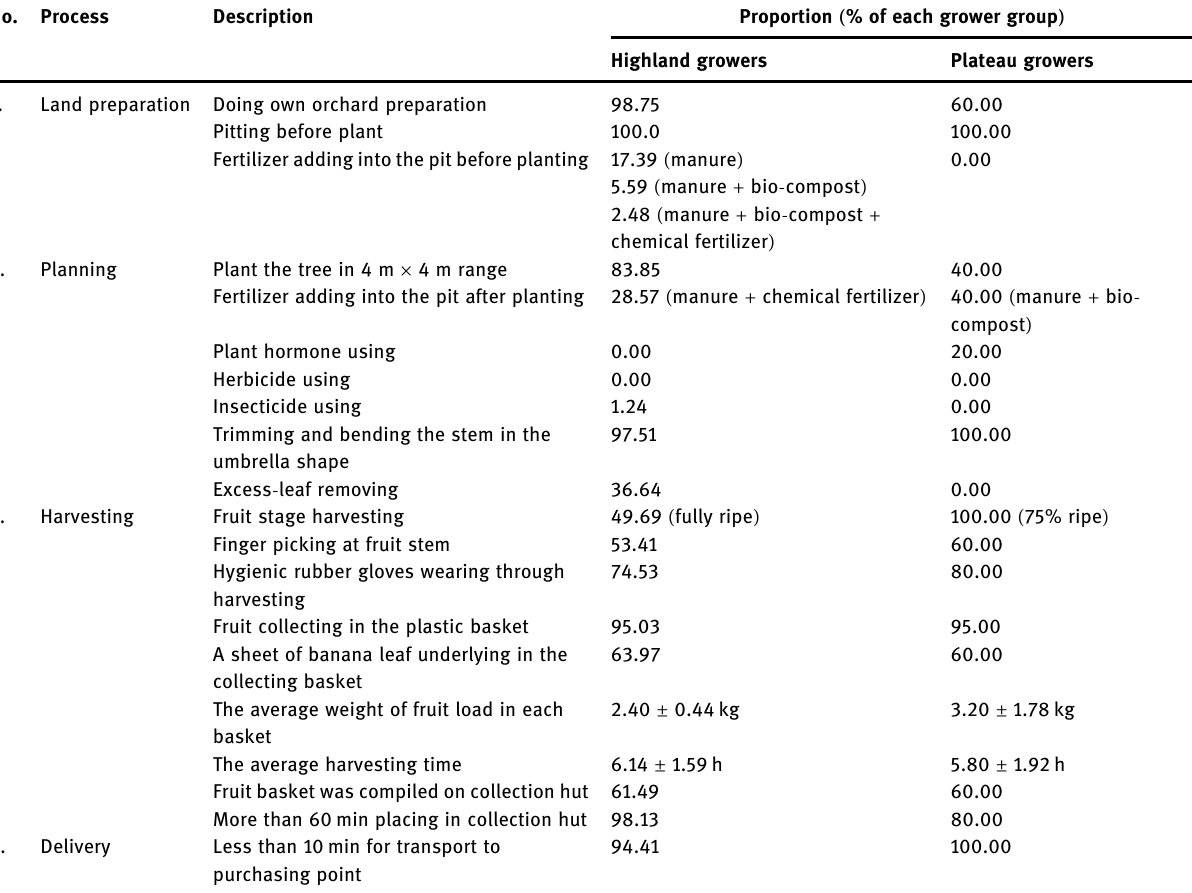
Table 2: Details of mulberry growers ’ production processes in the highland and plateau No.